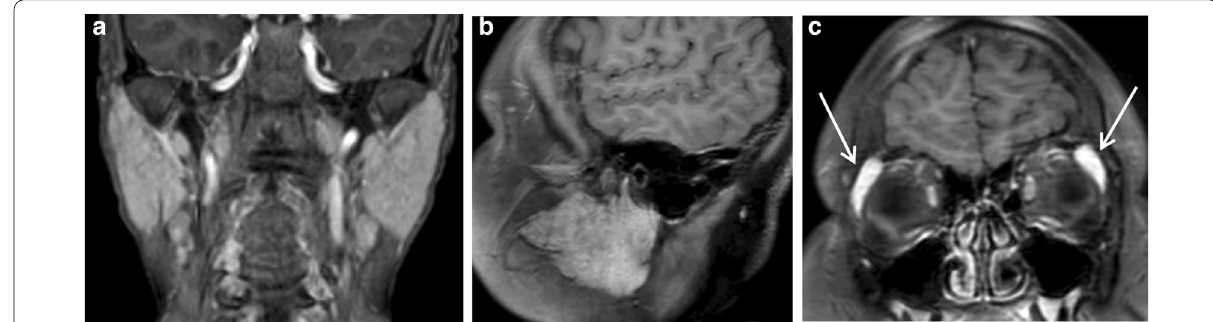
Fig. 21 Sarcoidosis. Bilateral infiltration and strong, homogeneous enhancement of parotid glands, on frontal and parasagittal fat sat T 1 ‑weighted image ( a and b ) and lacrimal glands, on frontal fat sat T 1 ‑weighted images ( c ), after intravenous administration of gadolinium